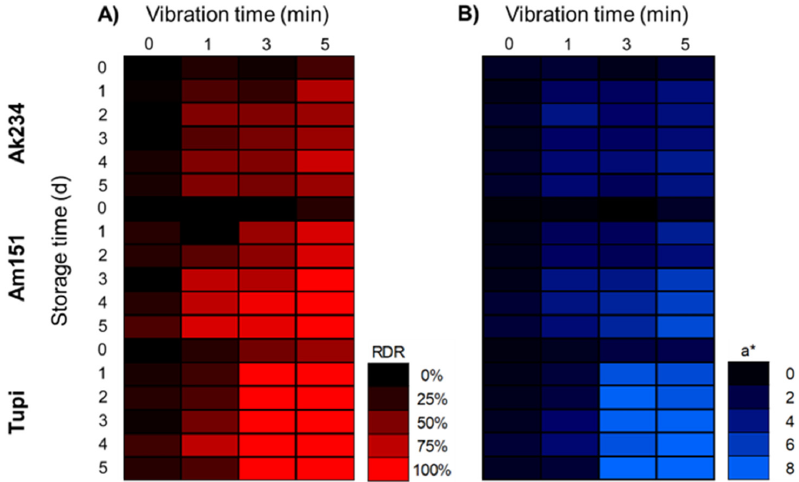
Figure 4. Portable vibration system allows to assess susceptibility of three blackberry cultivars to RDR. Heat map depicts average of ( A ) % of RDR and ( B ) a* color CIELab parameter in ‘Ak234 ′ , ‘Am151 ′ and ‘Tupi’ cultivars induced by different vibration (10 Hz and 0.5 g’ s) times (0, 1, 3 and 5 min) during 5 d of storage at 1 °C ( n = 15).